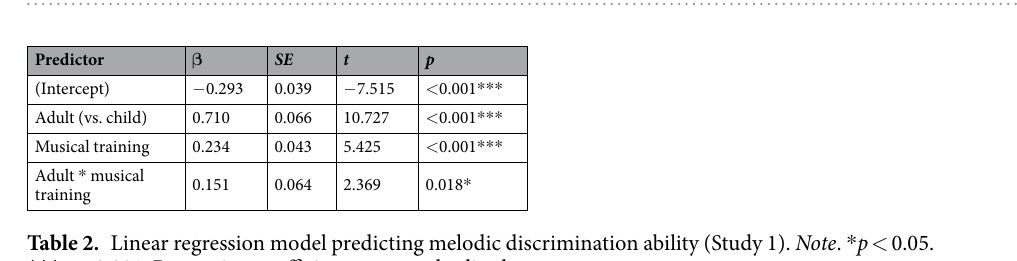
Table 2. Linear regression model predicting melodic discrimination ability (Study 1). Note . * p < 0.05. *** p < 0.001. Regression coefficients are